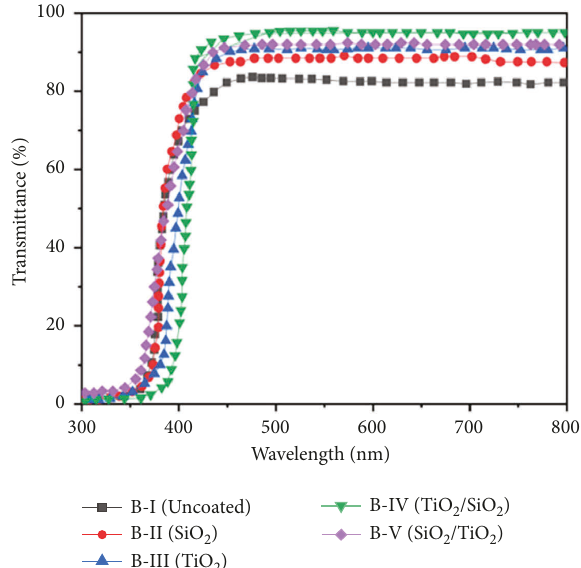
Figure 5: Optical transmittance spectra of various solar samples.